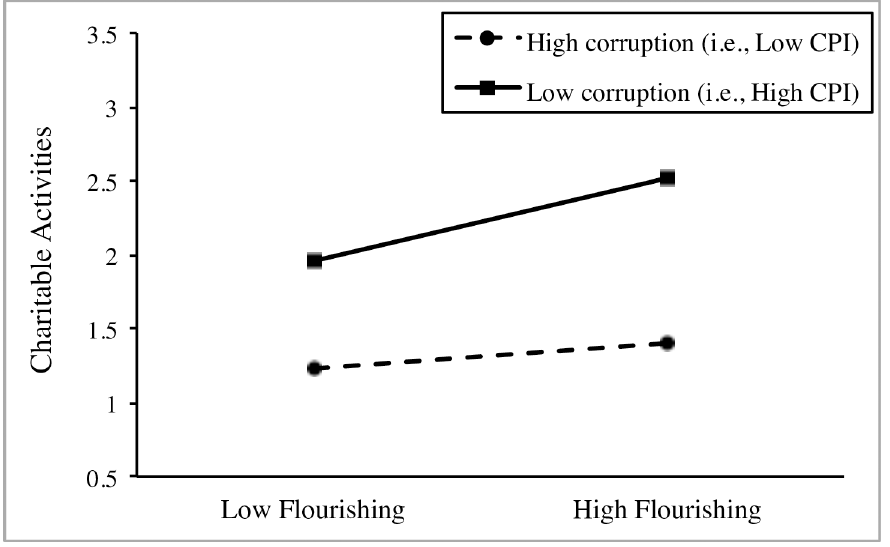
Fig 1. Cross-level interaction between flourishing and CPI on charitable activities in Study